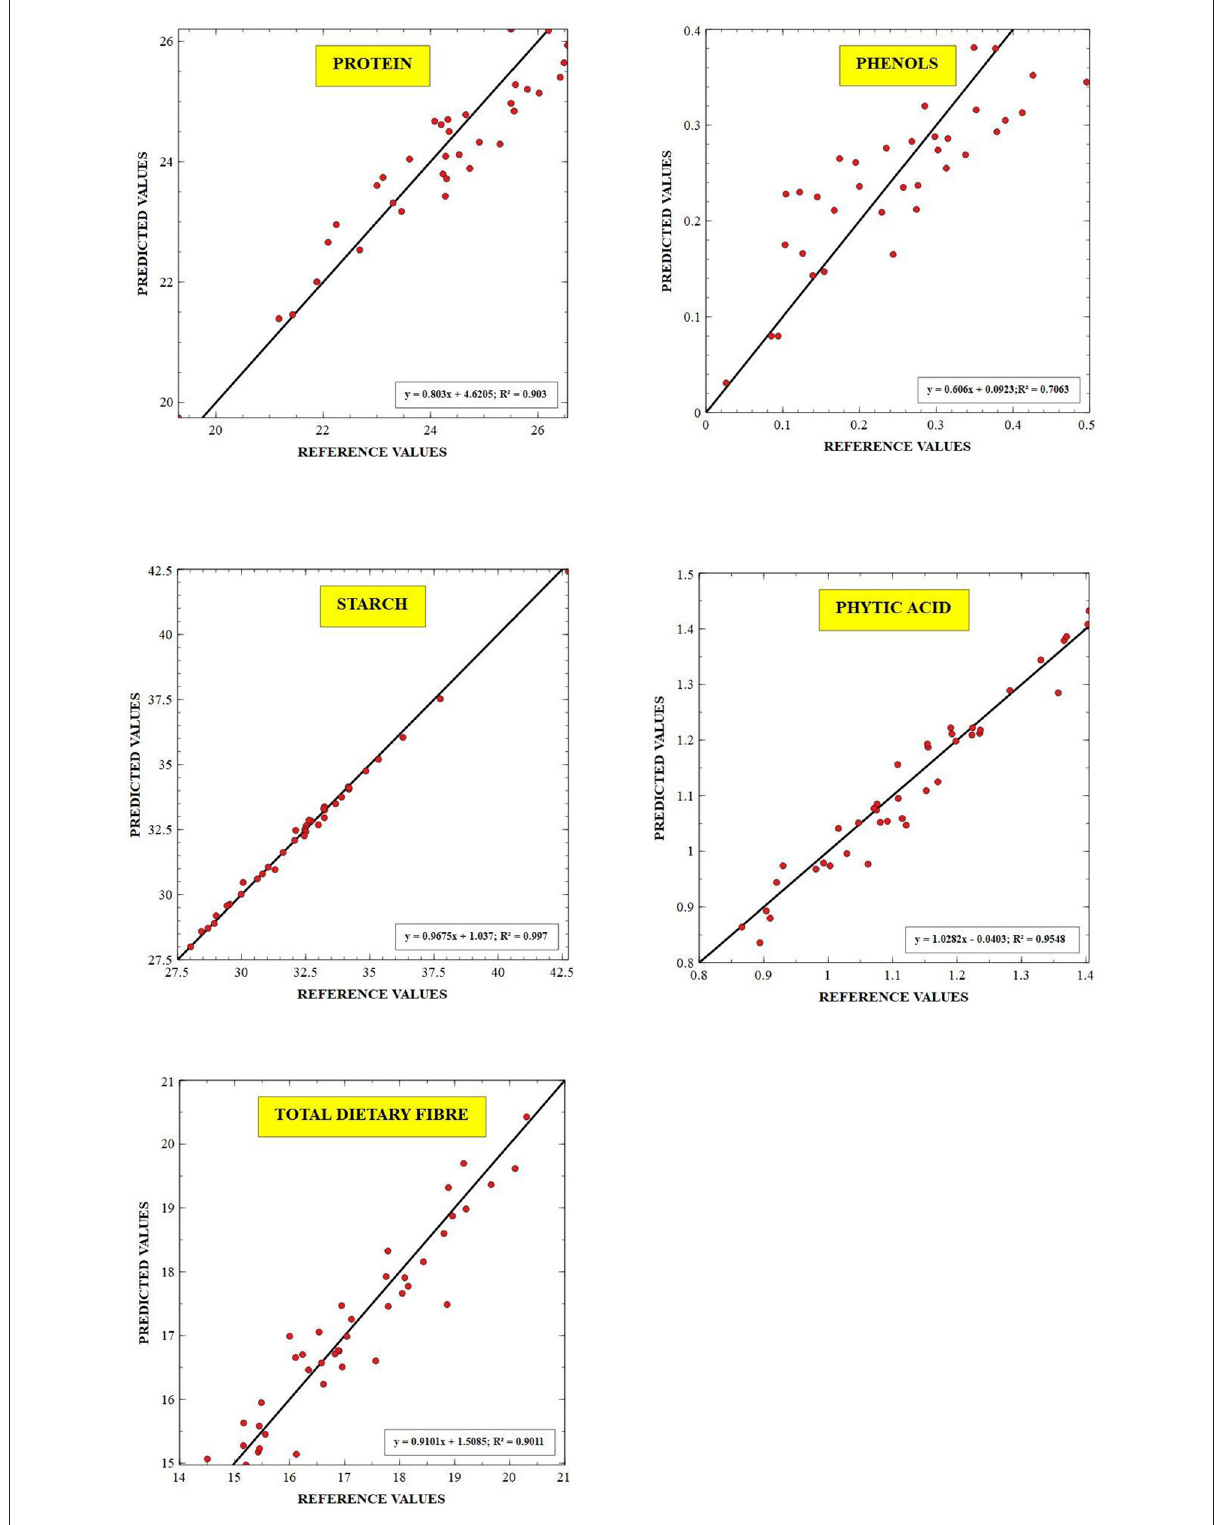
FIGURE3 Scatter plot between the reference vs. predicted values for protein, starch, TDF, total dietary fiber, phenols, and phytic acid. RSQ external –coefficient of determination for